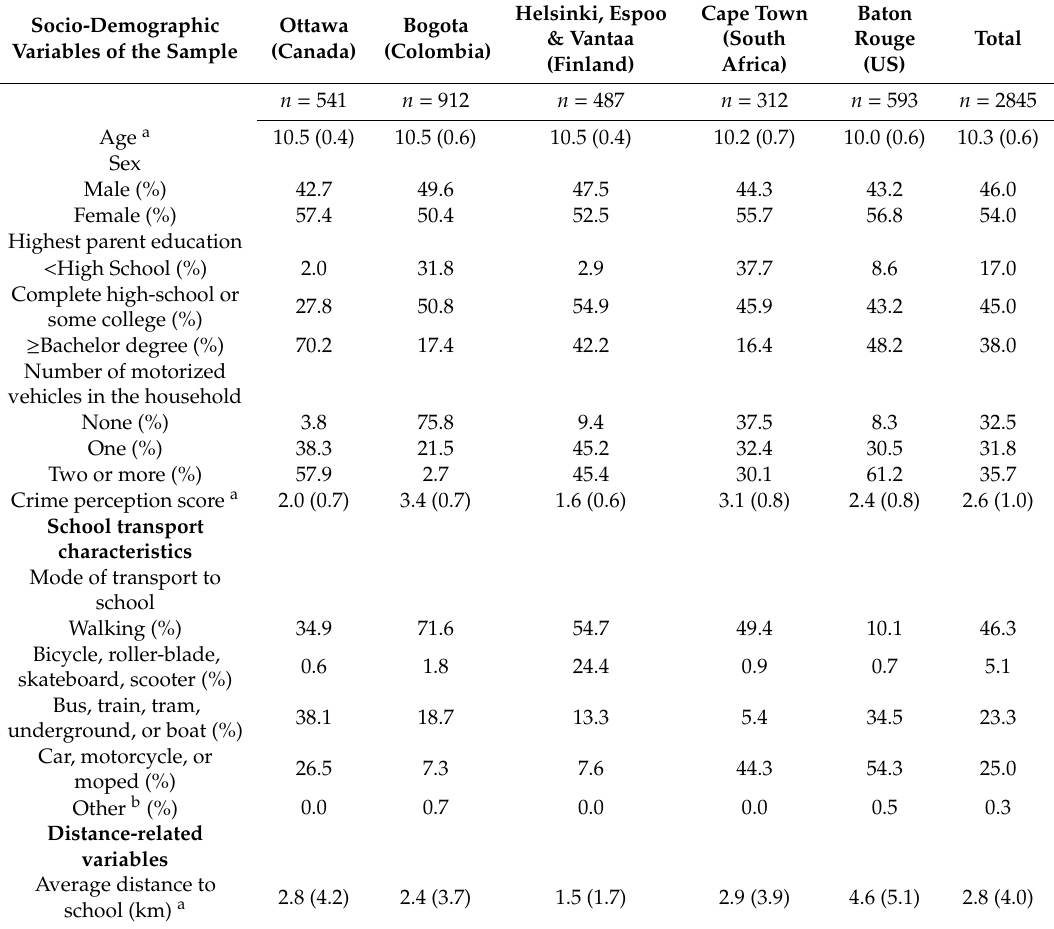
Table 2. Descriptive Characteristics of Participants Stratified by Study Site (n = 2845) in the International Study of Childhood Obesity, Lifestyle and the Environment